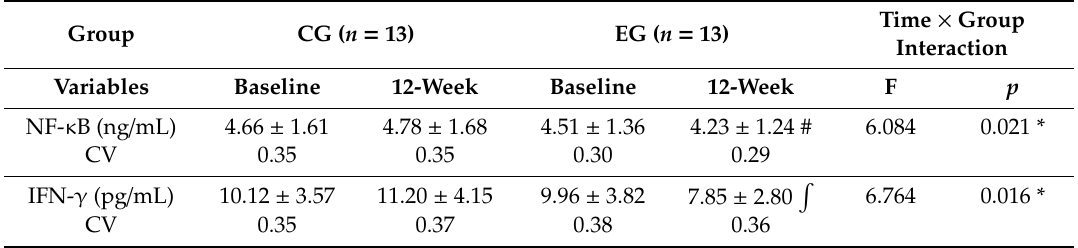
Table 4. The changes in the serum inflammation